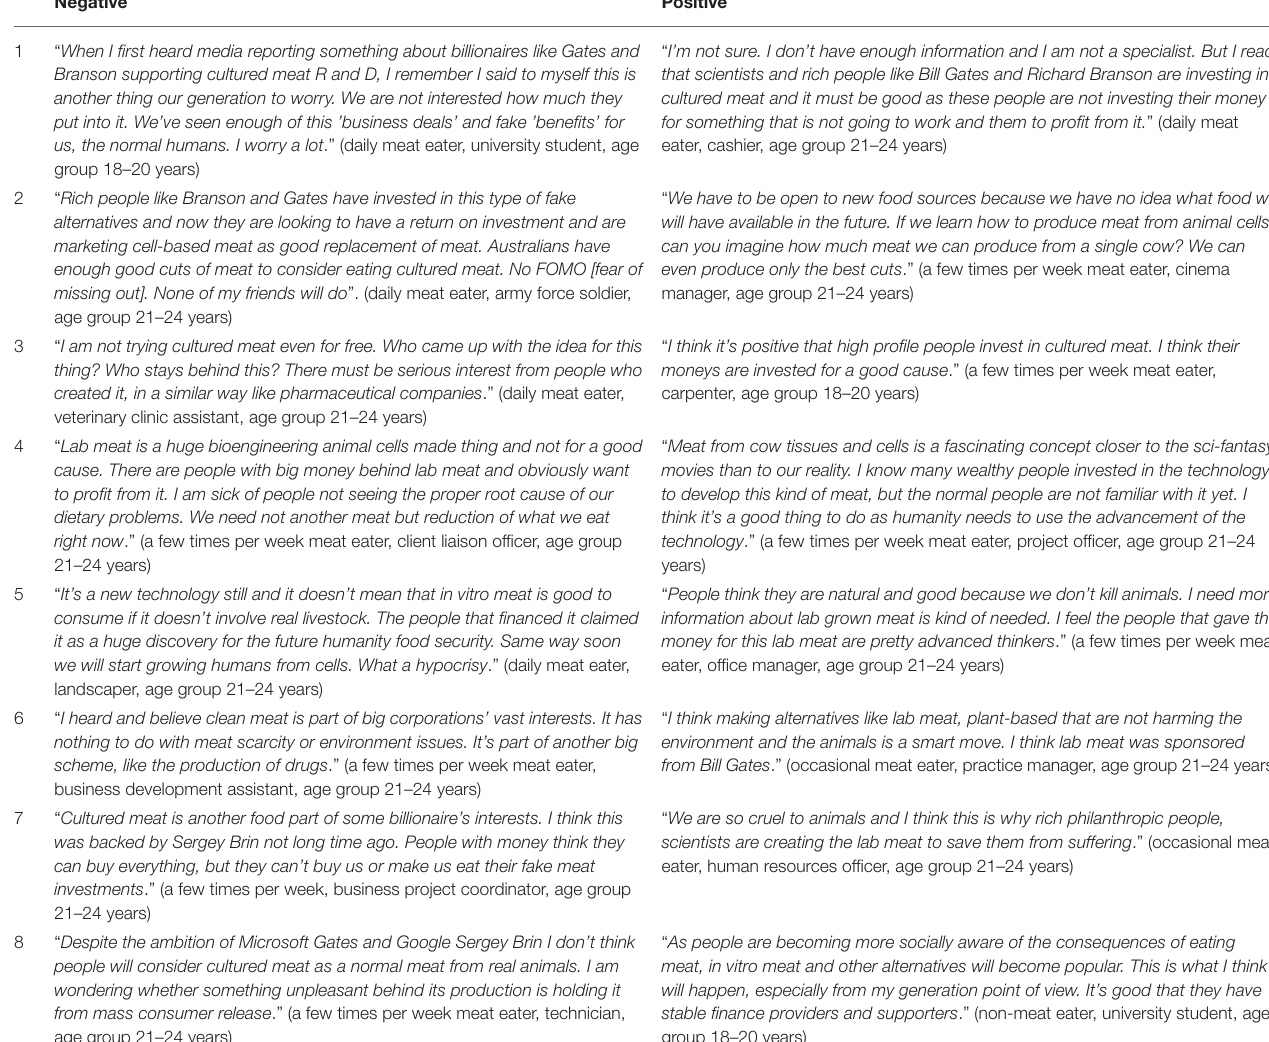
TABLE 10 | Sydney Gen Z’s attitudes toward investors in cultured meat. Negative